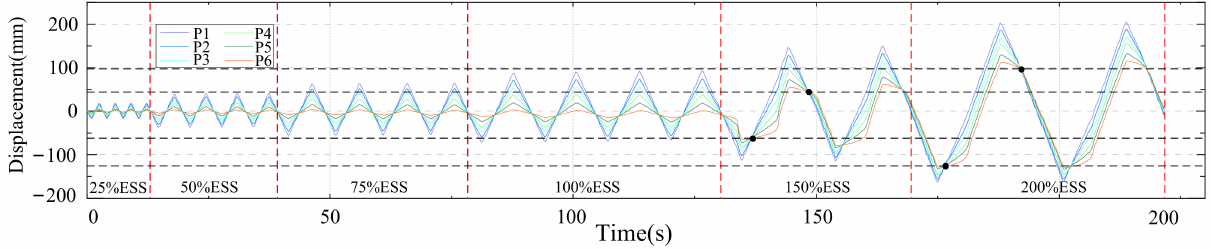
Figure 6. Pull-wire sensor displacement-time record of